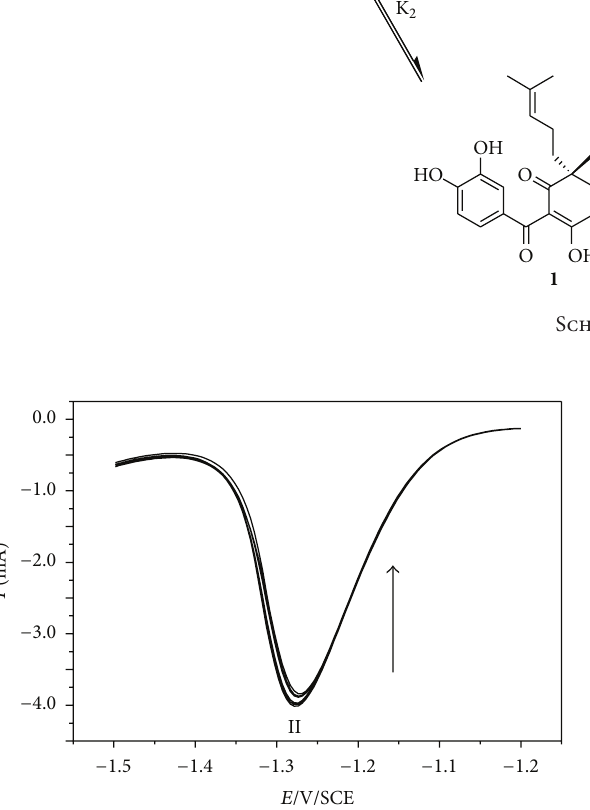
Figure 7: Effect of the resting potential on the net SW peak II, recorded with a thinfilm electrode in contact with an aqueous solution at pH = 1. The resting potential was − 0.3 V. The time increases in the direction of the arrow from 0, 25, 50, 75 to 100s. The other conditions are the same as for Figure 5.